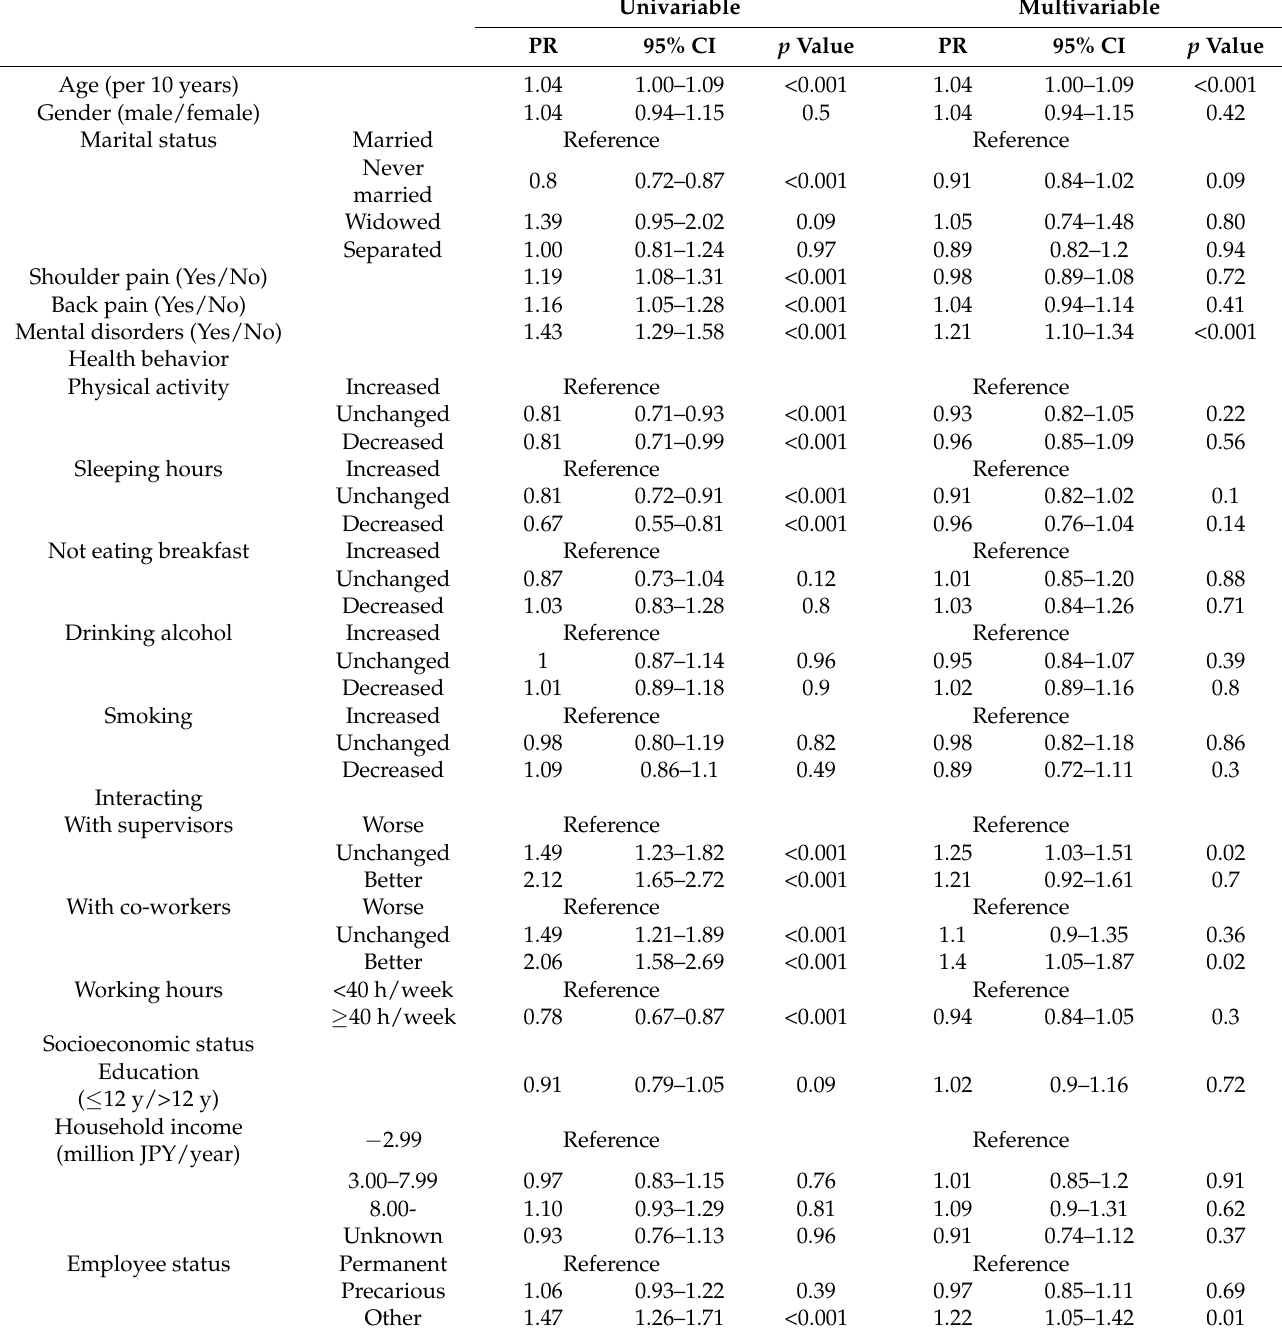
Table 3. Results of sensitivity analysis: the prevalence ratio and 95% confidence interval values for high work engagement using the Poisson regression model (univariable and multivariable